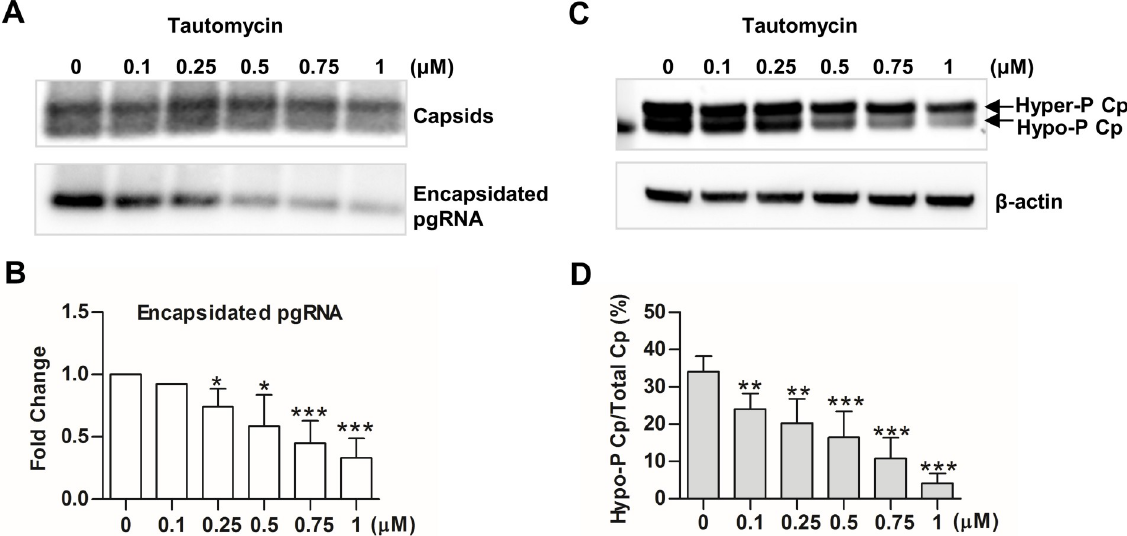
Fig 2. Tautomycin inhibits pgRNA encapsidation and Cp dephosphorylation. AML12polY63F cells were cultured in the absence of tet for 4 h and then mock-treated or treated with the indicated concentrations of tautomycin for 24 h. ( A ) Intracellular capsids and encapsidated pgRNA were detected by a particle gel assay. ( C ) Cp phosphorylation status was determined by a Western blot assay. ( B and D ) The band intensity of capsids, encapsidated RNA as well as hyper- and hypo-phosphorylated Cp in panels A and C were quantified by Gelpro32 software. The amount of encapsidated pgRNA was normalized to the amount of total capsids in each sample and presented as a fraction of the amount in mock-treated cells (B) The extent of Cp dephosphorylation was expressed as the percentage of hypophosphoryated Cp in total Cp for each sample (D). Data were derived from three independent experiments. � P < 0.05, �� P < 0.01, ��� P < 0.001, versus mock-treated cells (one-way ANOVA).